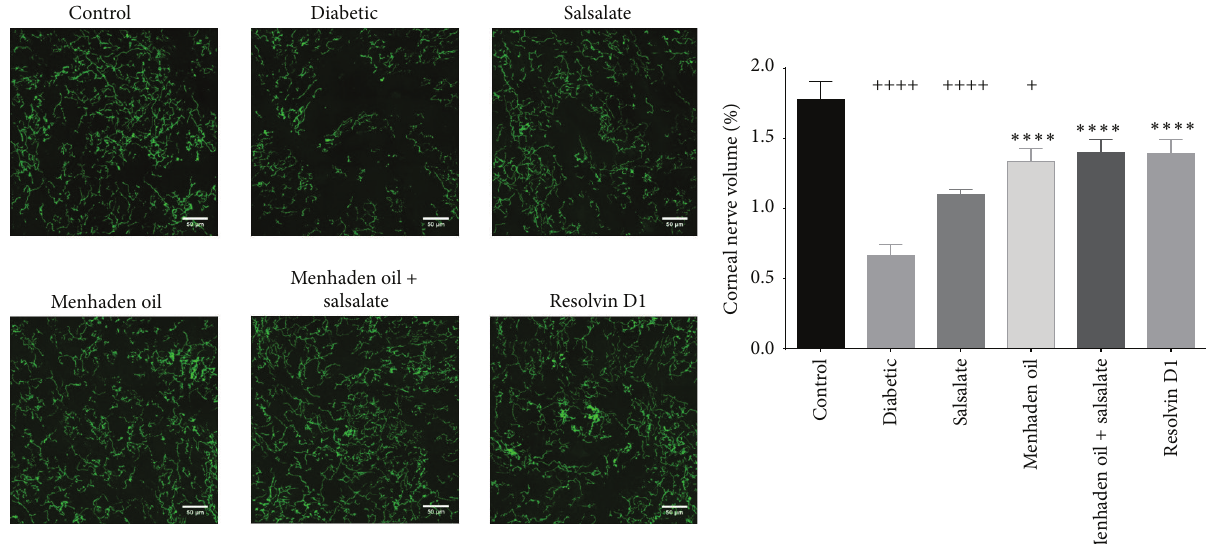
Figure 4: Immunohistochemical analysis of epithelial corneal nerves using neuronal class 𝛽 -III tubulin. Confocal images were obtained as described in the Materials and Methods and assessed using Imaris software for the percentage of nerve volume relative to the total volume imaged. Data are presented in percentage of nerve volume relative to total volume imaged ± SEM. The number of animals per group was the same as described in Table 3. + 𝑝 < 0.05 compared to control group, ++++ 𝑝 < 0.0001 compared to control group, and ∗∗∗∗ 𝑝 < 0.0001 compared to untreated diabetic